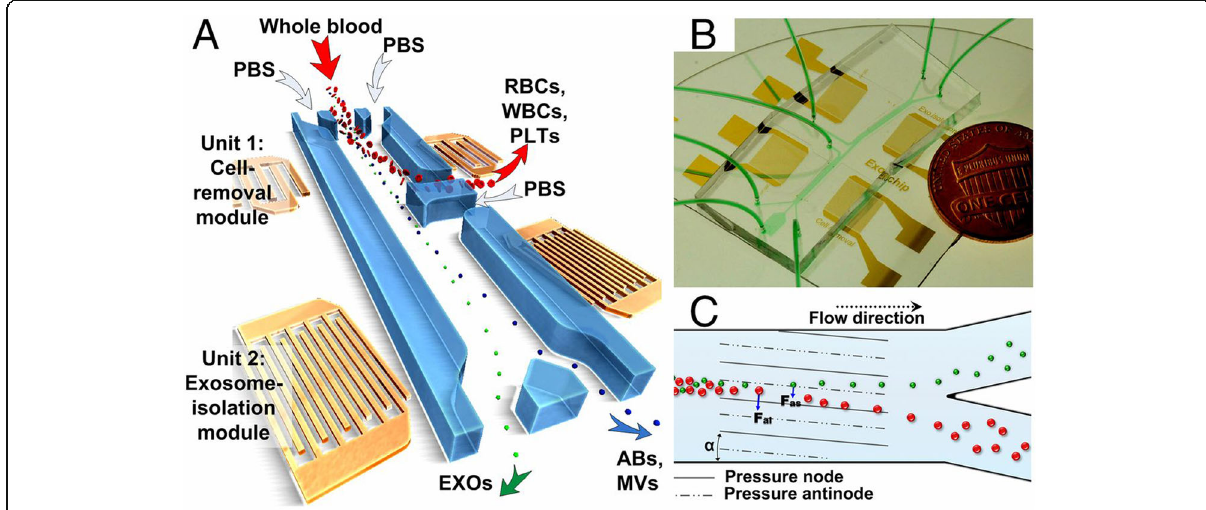
Fig. 2 The platform underlying integrated acoustofluidic device for isolating exosomes